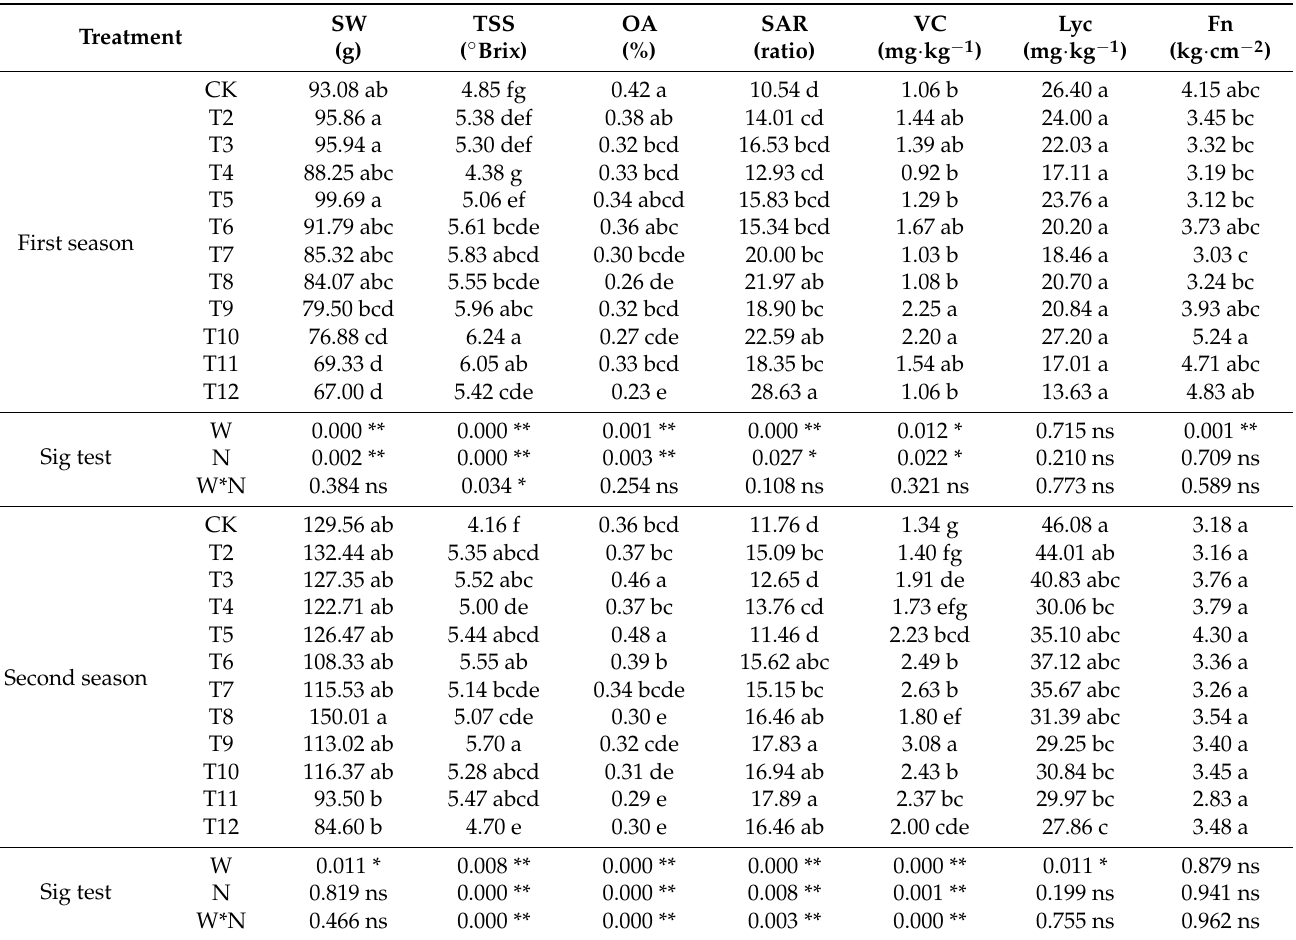
Table 3. Single fruit quality parameters under different water and nitrogen treatments in the first and second seasons of